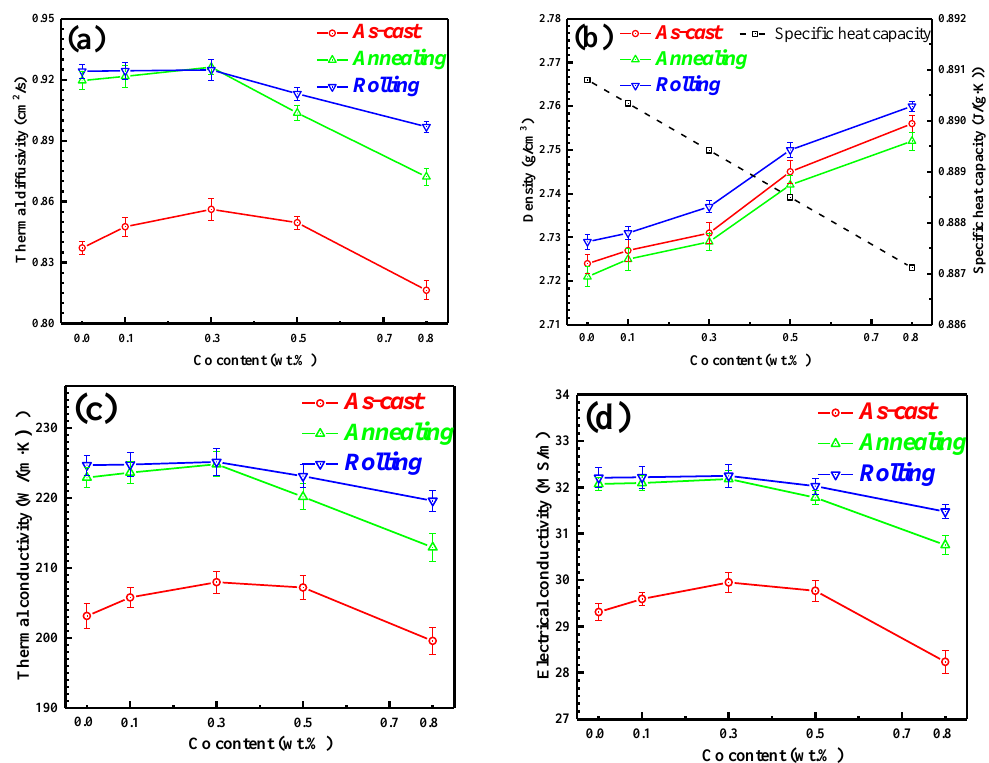
Figure 7. The various properties of the Co-modified Al-2%Fe alloys in different states; ( a ) Thermal diffusivity; ( b ) Density and specific heat capacity; ( c ) Thermal conductivity; ( d ) Electrical conductivity.